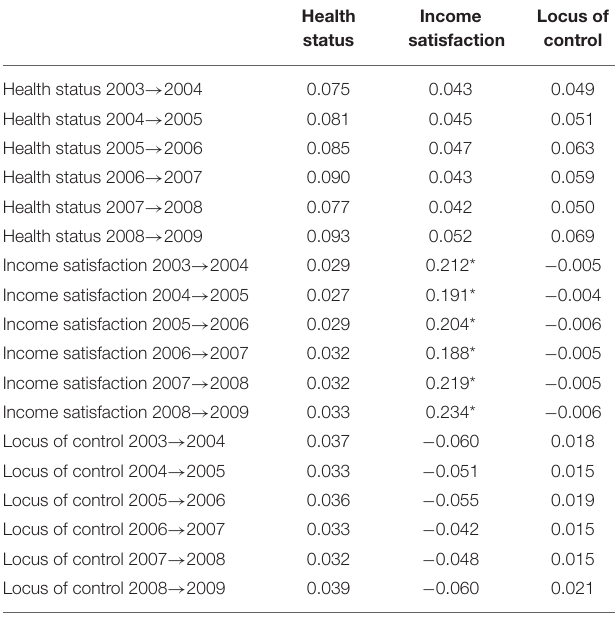
TABLE 8 | Standardized auto-regressive and cross-lagged effects.